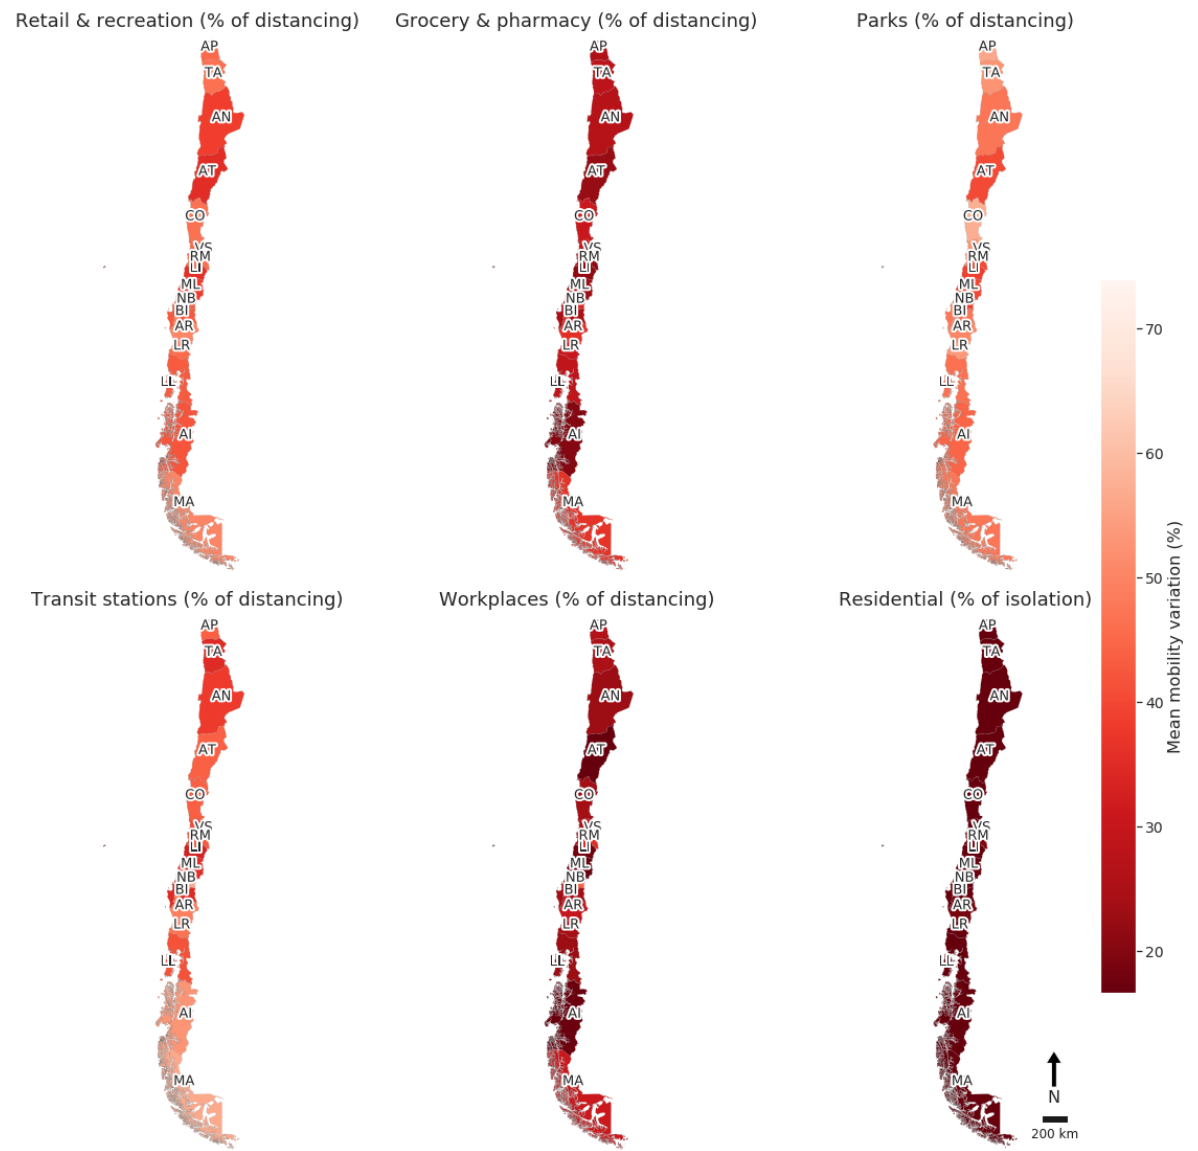
Figure 17. Average variation of mobility from baseline (3 January to 6 February 2020) for the regions of Chile during the period from 15 February to 31 May 2020. Lighter colours indicate greater distancing or greater isolation in residential areas. Source of basic data: Covid-19 Community Mobility Reports,